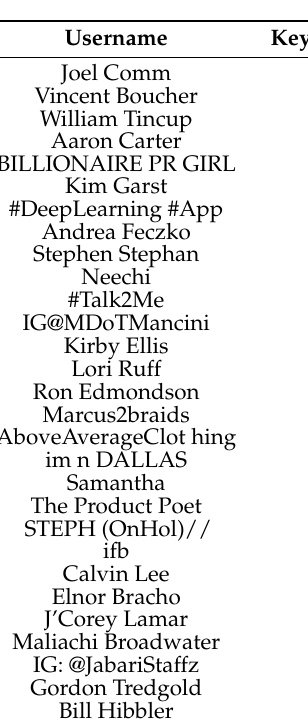
Table 6. Mood research results using the enhanced RST discrimination method